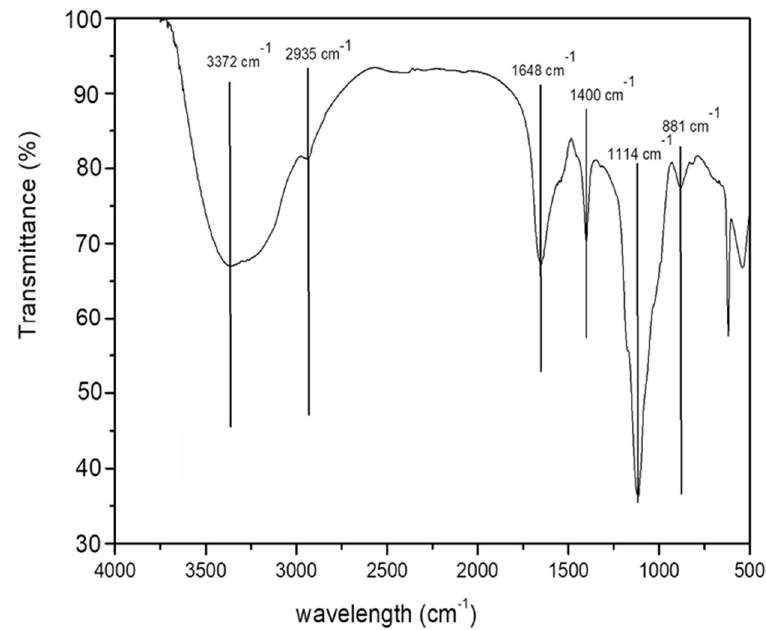
Figure 8. FTIR analysis of exopolysaccharides (EPSs) produced from T. borchii cultivated by sub- merged fermentation.